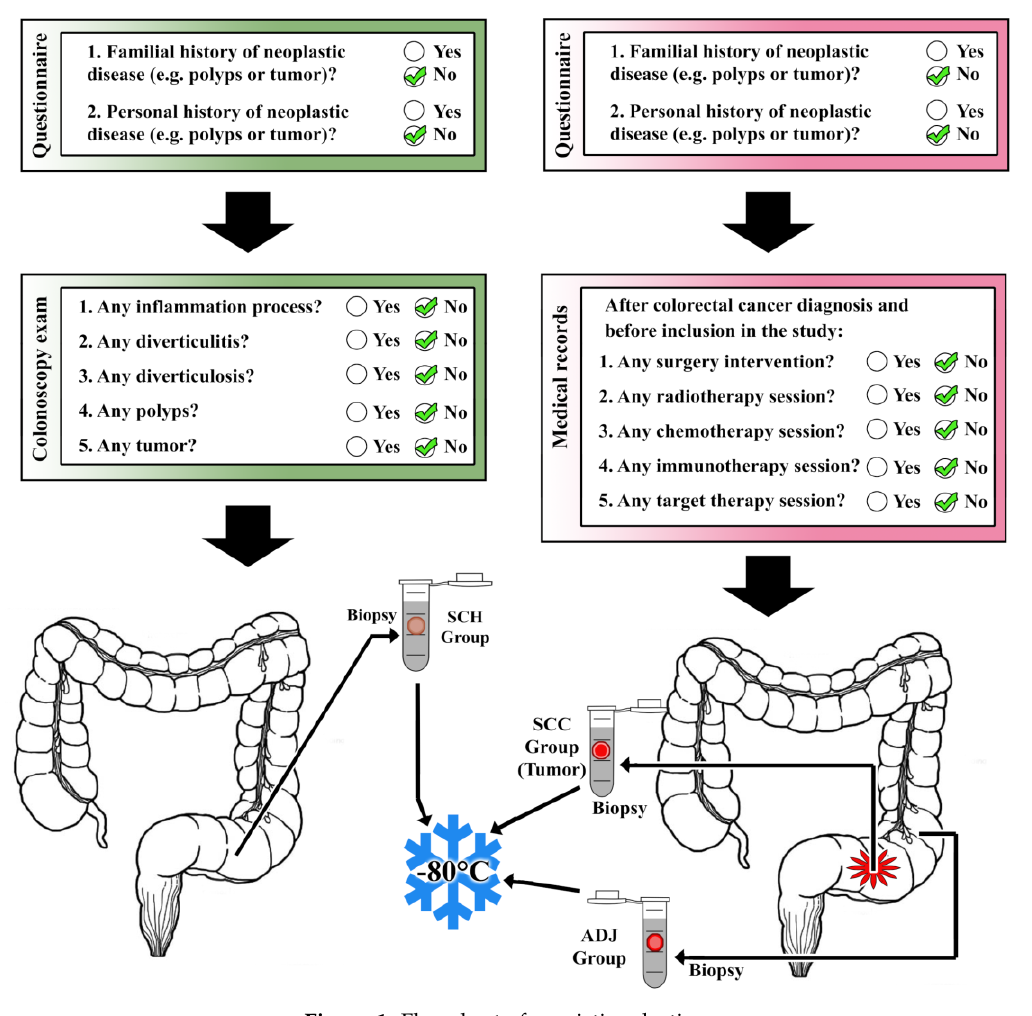
Figure 1. Flowchart of casuistic selection.